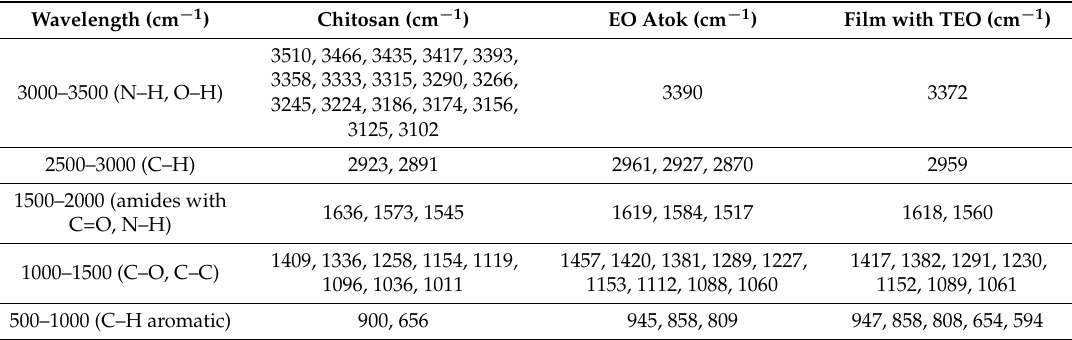
Table 4. The main signals of Fourier-transform infrared (FTIR) analysis.